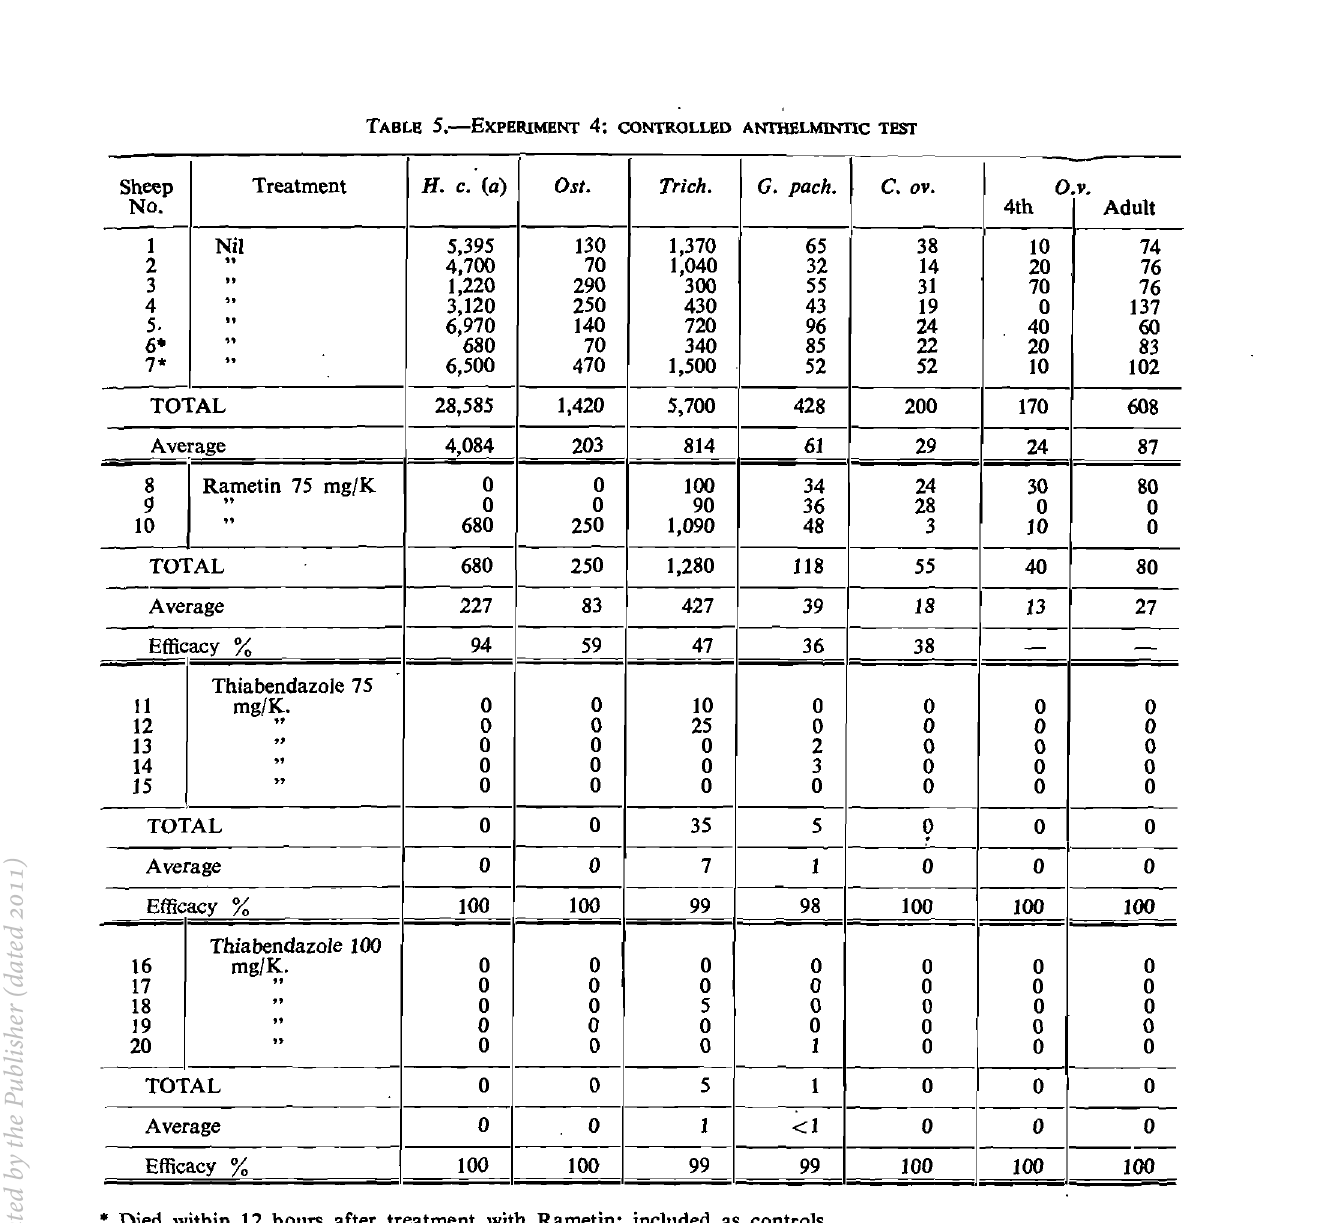
G. pach. = Gaigeria pachysce/is Ost. = Ostertagia spp. C. o'v. = Chabertia ovina Trich. = Trichostrongylus spp: O. v. = Oesophagostomum venulosum Experiment 5: Critical Anthelmintic Test then the sheep were